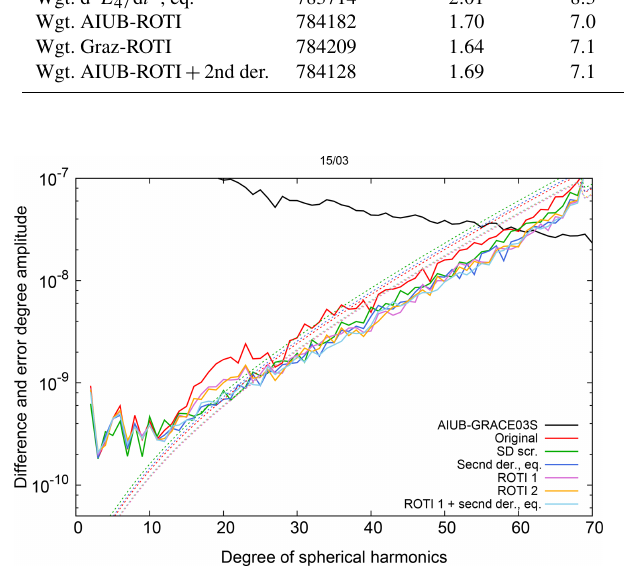
Figure 9. Difference (solid lines) and error (dashed lines) de- gree amplitude for monthly Swarm A gravity fields w.r.t. AIUB- GRACE03S, March